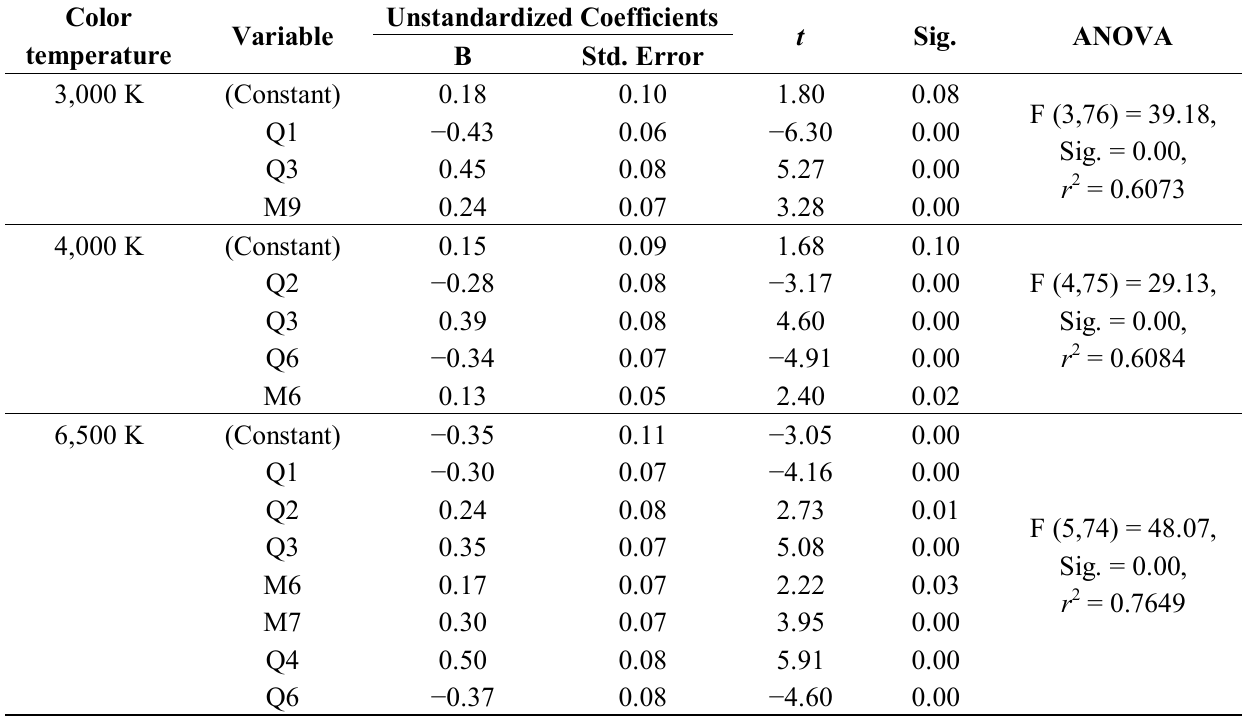
Table 5. Prediction model of visual comfort for lighting